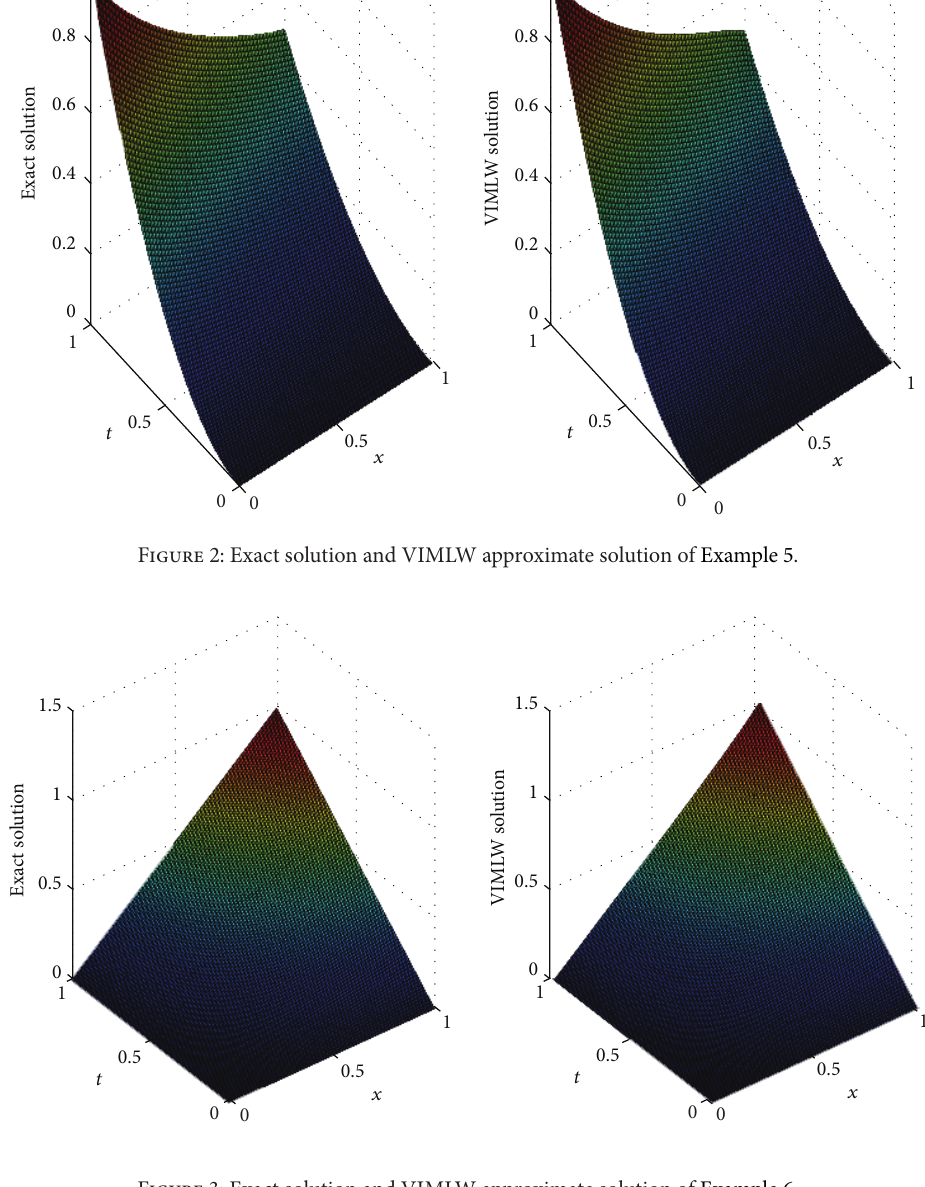
Figure 3: Exact solution and VIMLW approximate solution of Example